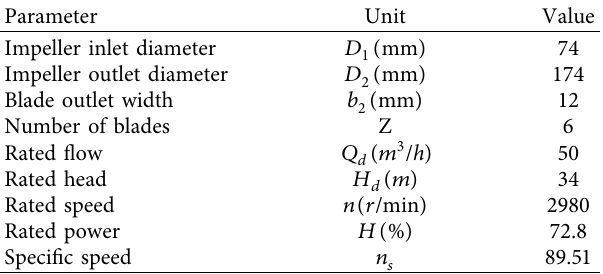
Figure 6: (a) Schematic diagram. (b) Physical drawing of the Table 5: Design parameters of centrifugal pump for test.